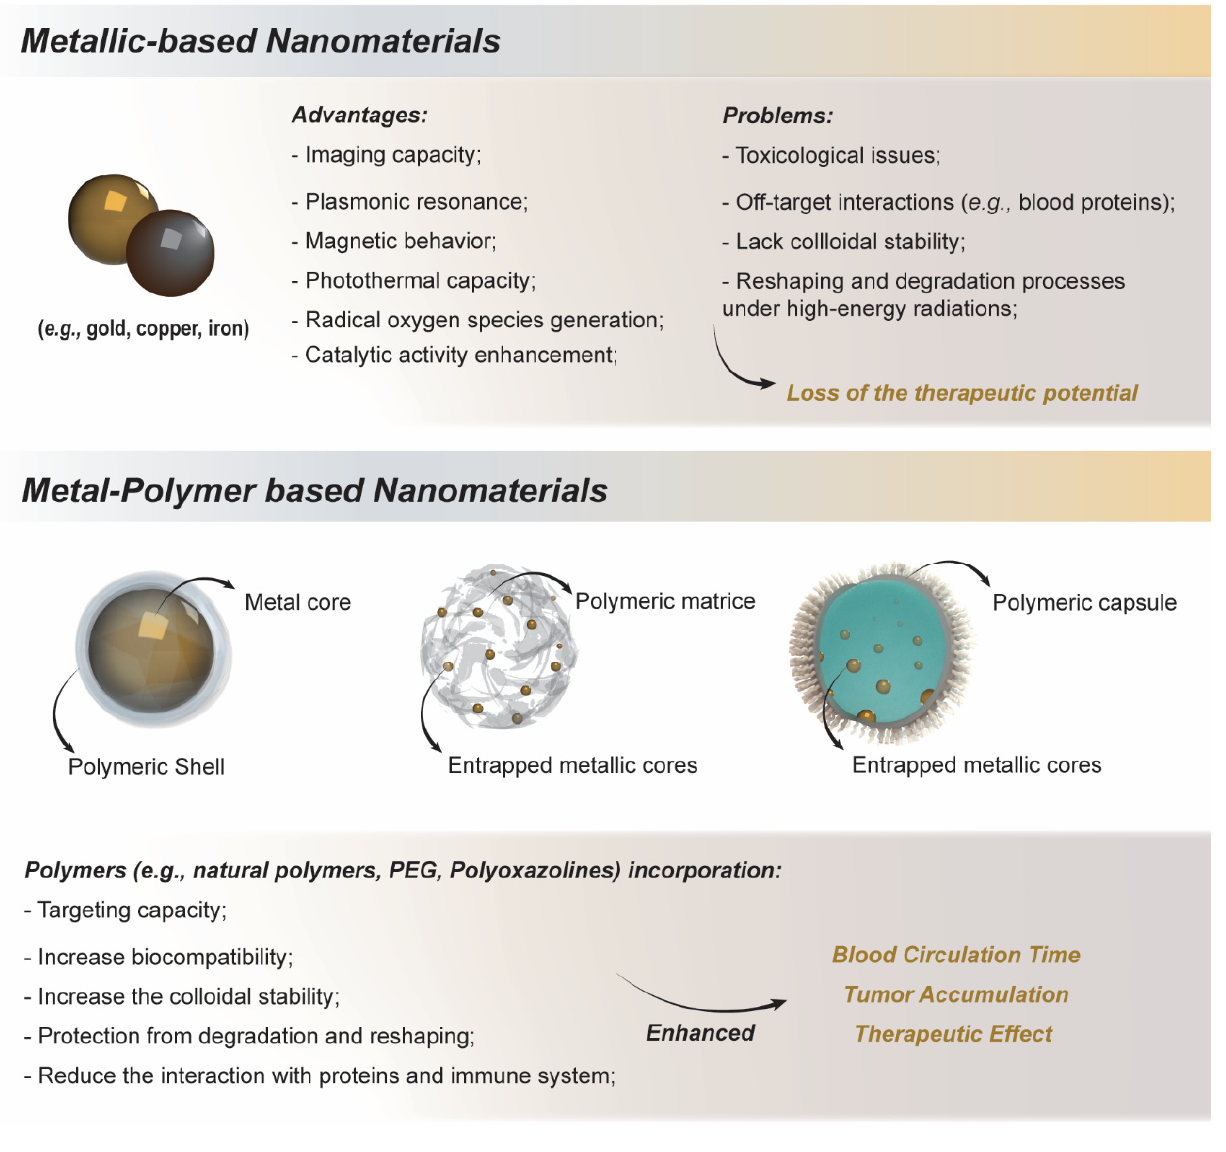
Figure 1. Overview of the properties of metallic nanoparticles, advantages of the polymers’ inclu ‐ sion, and representation of the most common structural organizations of the metal ‐ polymer nano ‐ hybrids/complexes.